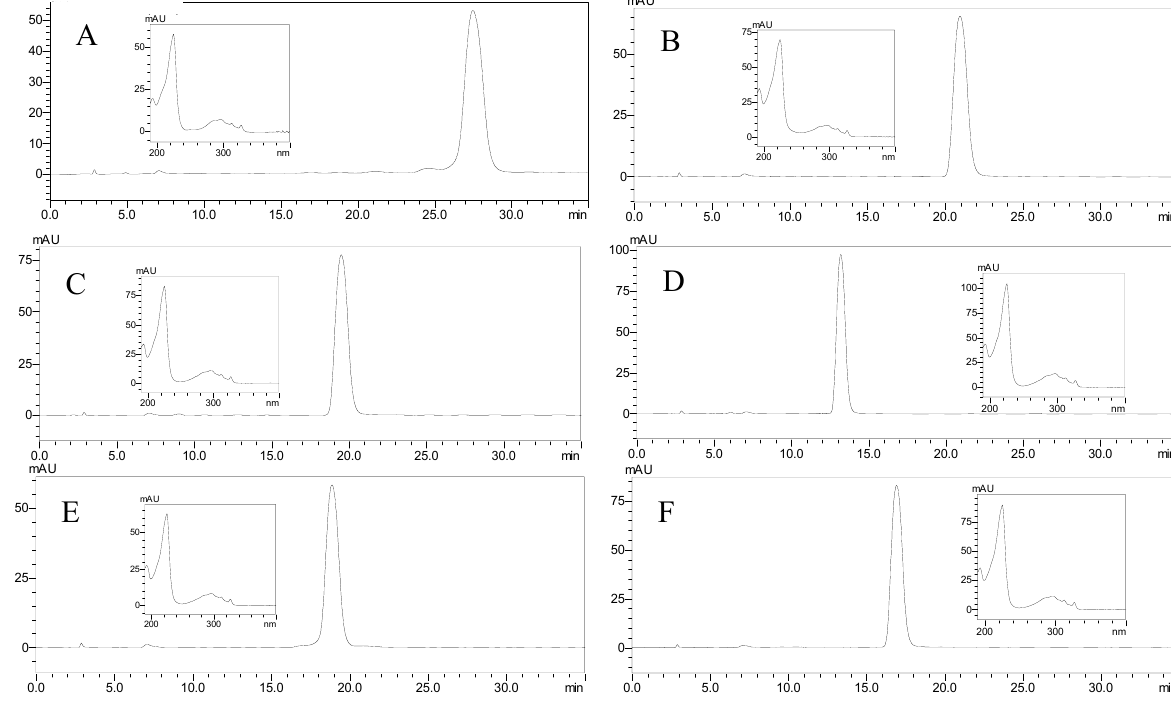
Figure 3. HPLC analysis and UV spectra of each HSCCC fraction. ( A ) diepoxin κ ( 1 ) from ( 2 ) from HSCCC peak fraction III; HSCCC peak fraction II; ( B ) palmarumycin C 13 ( 3 ) from HSCCC peak fraction IV; ( D ) palmarumycin C ( 4 ) from ( C ) palmarumycin C 16 15 HSCCC peak fraction V; ( E ) diepoxin δ ( 5 ) from HSCCC peak fraction VI; ( F ) diepoxin γ ( 6 ) from HSCCC peak fraction VII. The HPLC retention time of each HSCCC peak fraction ( i.e ., II–VII) was 27.48, 20.95, 19.15, 13.19, 18.87 and 16.92 min,